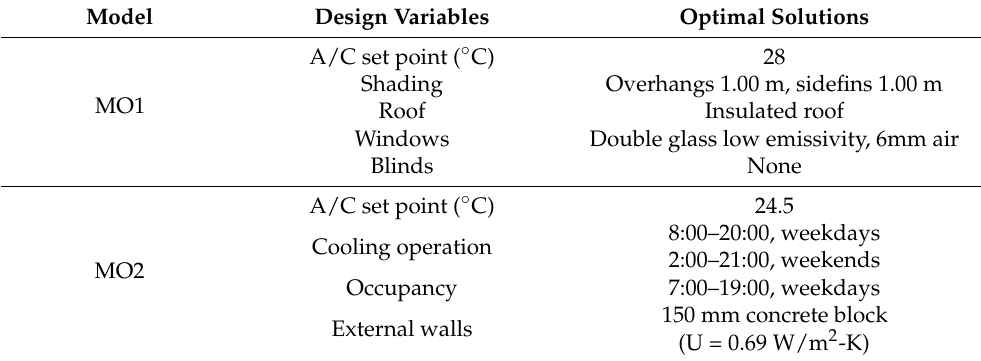
Table 10. Optimal options selected for modified design variables in both compared studies.